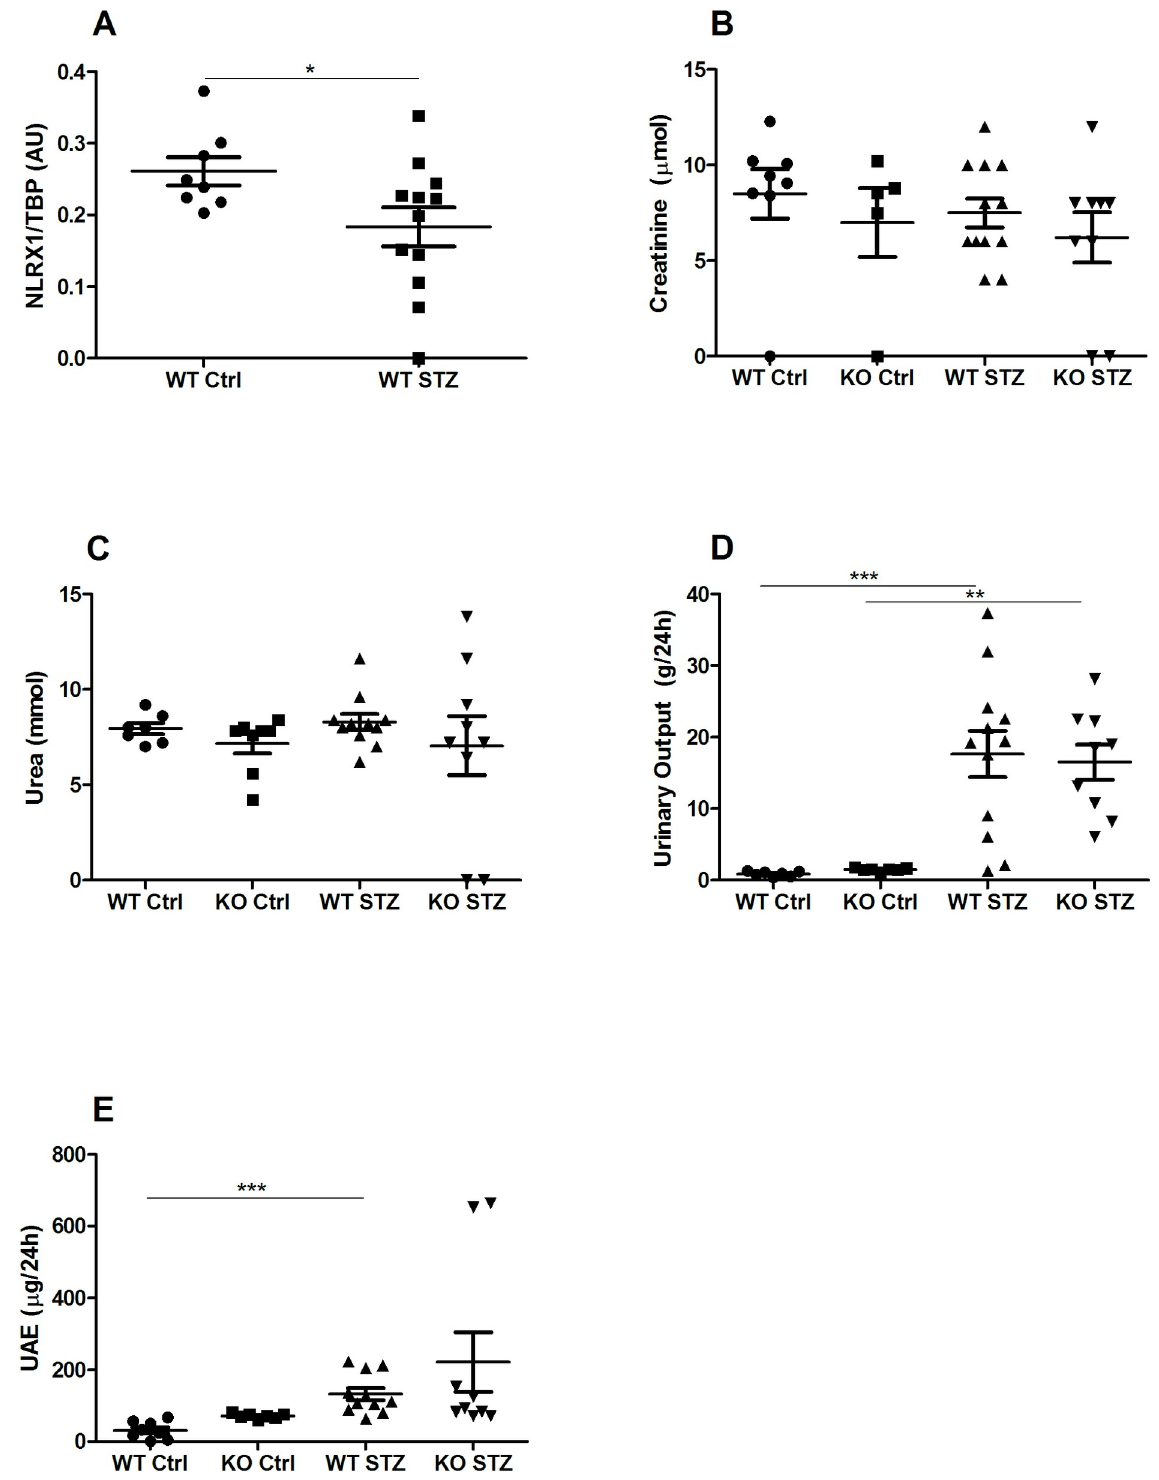
Fig 3. Functional renal markers: NLRX1 mRNA expression, plasma creatinine, plasma urea, urinary output, and urinary albumin excretion. (A) NLRX1 mRNA expression measured in renal tissue of non-diabetic and diabetic WT mice. (B-C) Plasma creatinine and plasma urea measured in the automated Roche cobas c702 Chemistry Analyzer. Urinary output and UAE measured in 24-hour urine. (D-E) UAE was measured using the Mouse albumin ELISA quantification kit. Data shown as mean ± SEM. � p < 0.05, �� p < 0.01, ��� p < 0.001. UAE = Urinary albumin